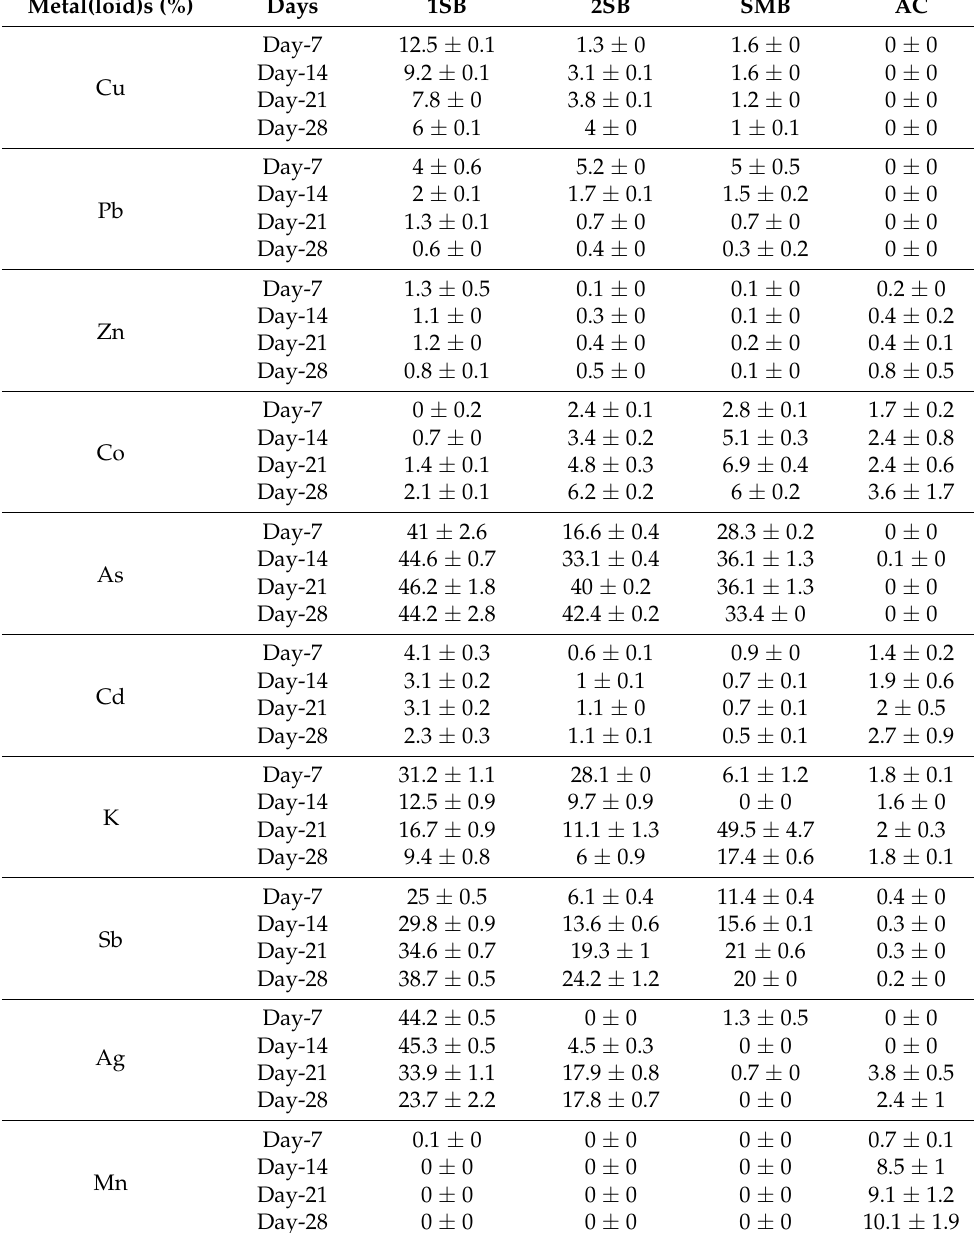
Table A1. Percentages of the metal(loid)s extracted from the Neves Corvo waste rock by T. cyclica via one-step bioleaching (1SB), two-step bioleaching (2SB), spent medium bioleaching (SMB), and the abiotic control (AC). Values are the average of duplicate flasks ± standard deviations. Metal(loid)s